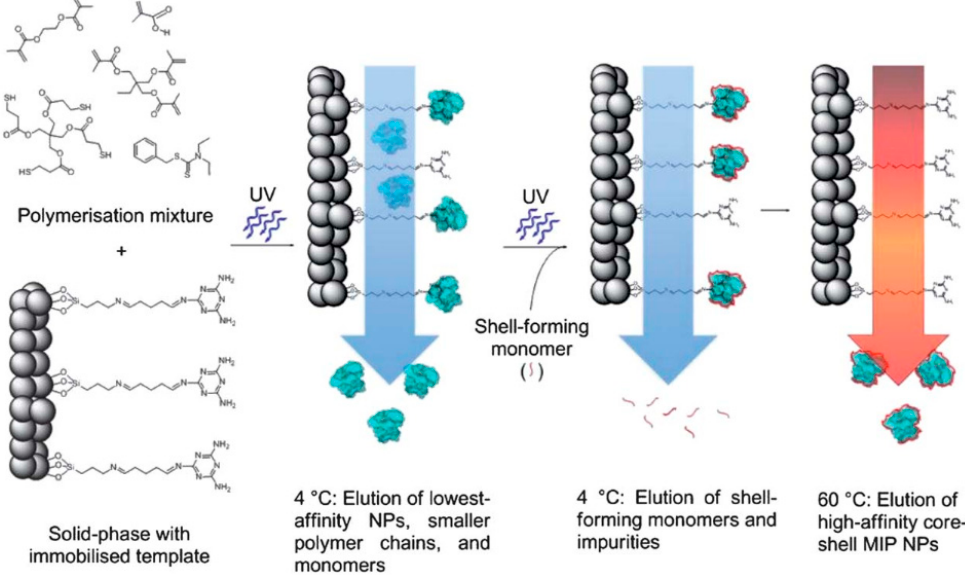
Figure 5. Schematic representation of core-shell MIP NPs. The template molecule was immobilized onto a solid support. A polymerization mixture (containing functional and cross-linking monomers, initiators) were loaded on this solid support. Polymerization was initiated via UV light. Un-reacted monomers and low-affinity particles were eluted from the solid phase at low temperature where the high affinity particles remained bound to the template. The high-affinity particles were subsequently grafted with a secondary monomer and an application of UV-light. After polymerization, high-affinity core-shell MIP NPs were eluted from the shell by increasing the temperature up to 60 ◦ C (reproduced from [58] with permission).